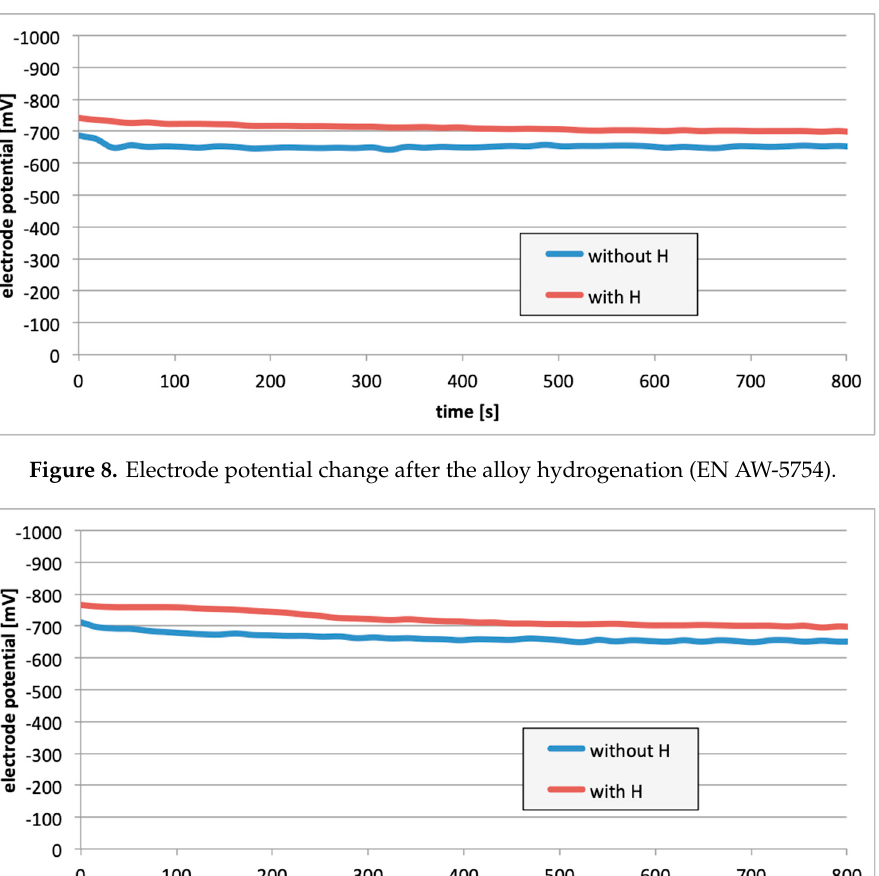
Figure 7. Electrode potential change after the alloy hydrogenation (EN AW-1050A).